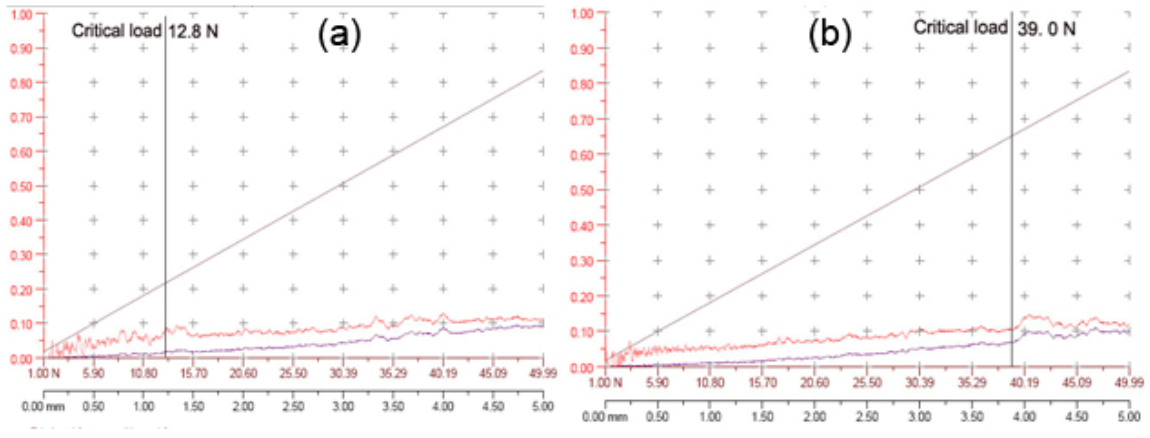
Figure 10. Friction behavior and critical load for progressive load scratch test of TiAlN films: a) The smallest adhesion, b) The largest adhesion.